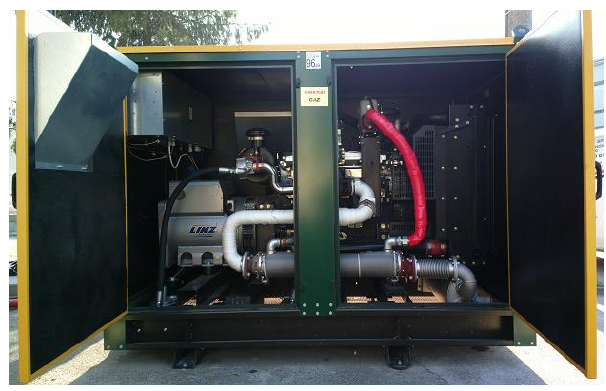
Fig. 3. Side-view photo of the cogeneration set CHP 64 kVA